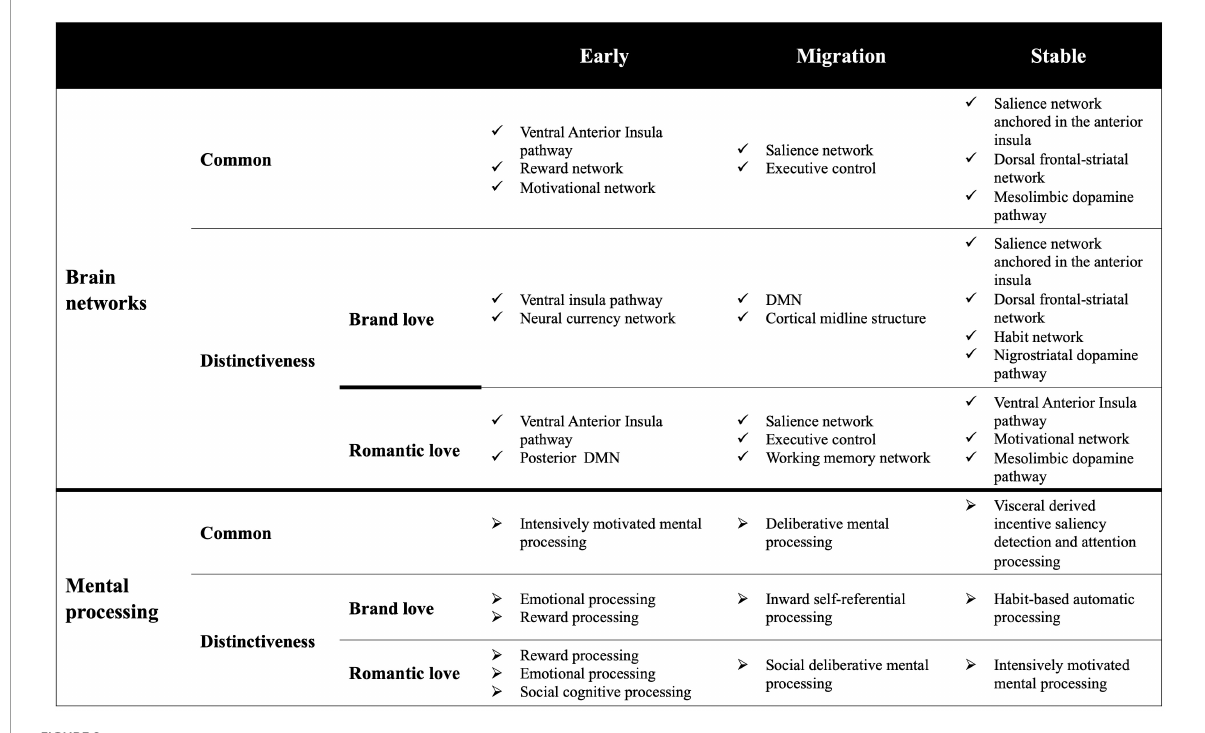
FIGURE9 Brain networks and mental processing at each love relationship stage. DMN; default mode